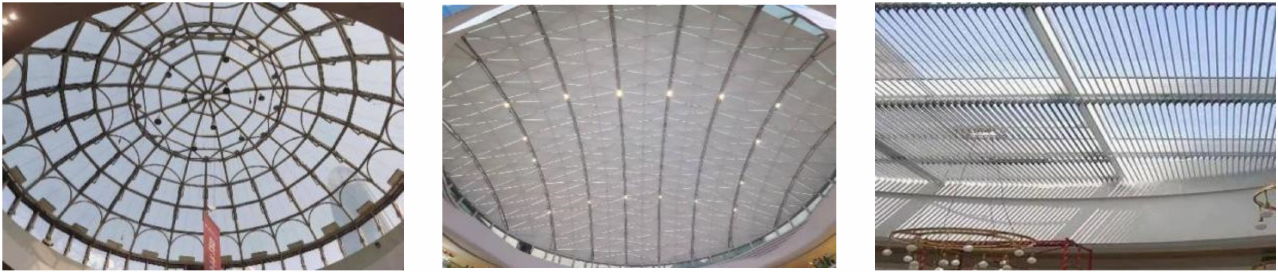
Figure 10. Commercial atrium shading types (Author self